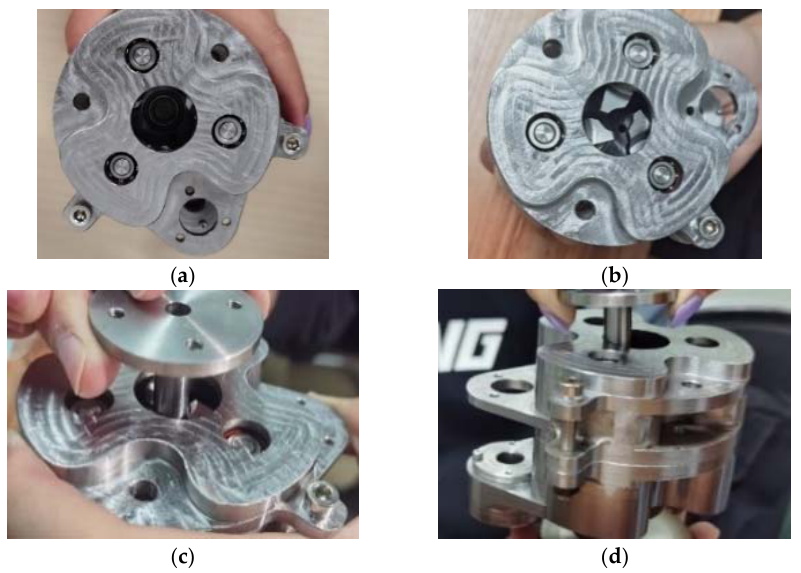
state. (c) Locking claw lock locking rod. (d) Locking claw locking test